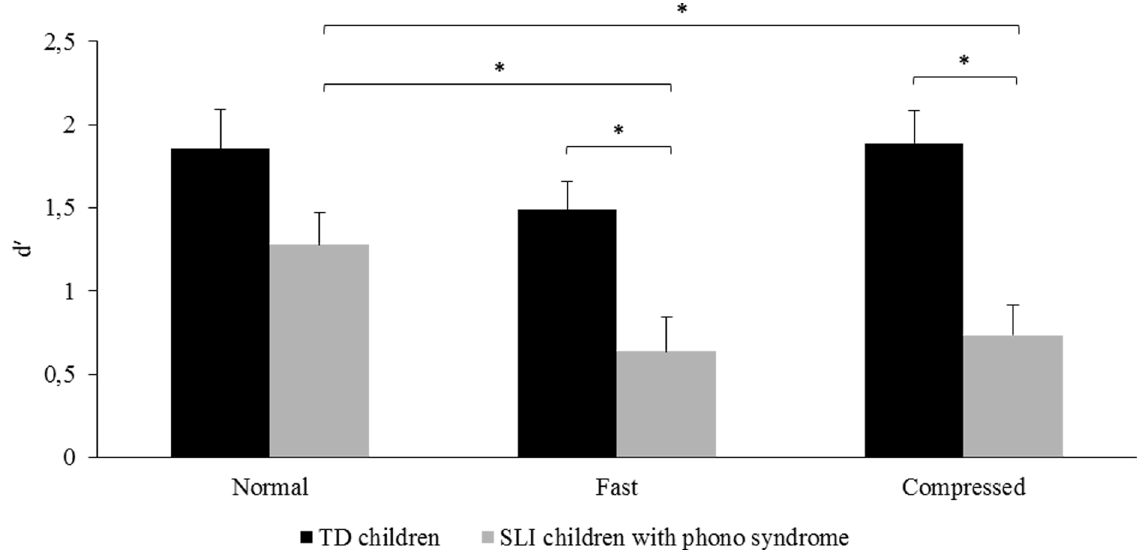
Fig 2. Sensitivity to semantic incongruity in children with SLI diagnosed with a phonological-syntactic syndrome as a function of Speech Rate. Mean d 0 values are presented for children with a phonological-syntactic syndrome (phono SLI) and chronological age-matched TD children for the three speech rate conditions (natural normal, natural fast and time-compressed). ( (cid:3) ) indicates a significant difference between conditions (p < .05). Error bars indicate standard errors.